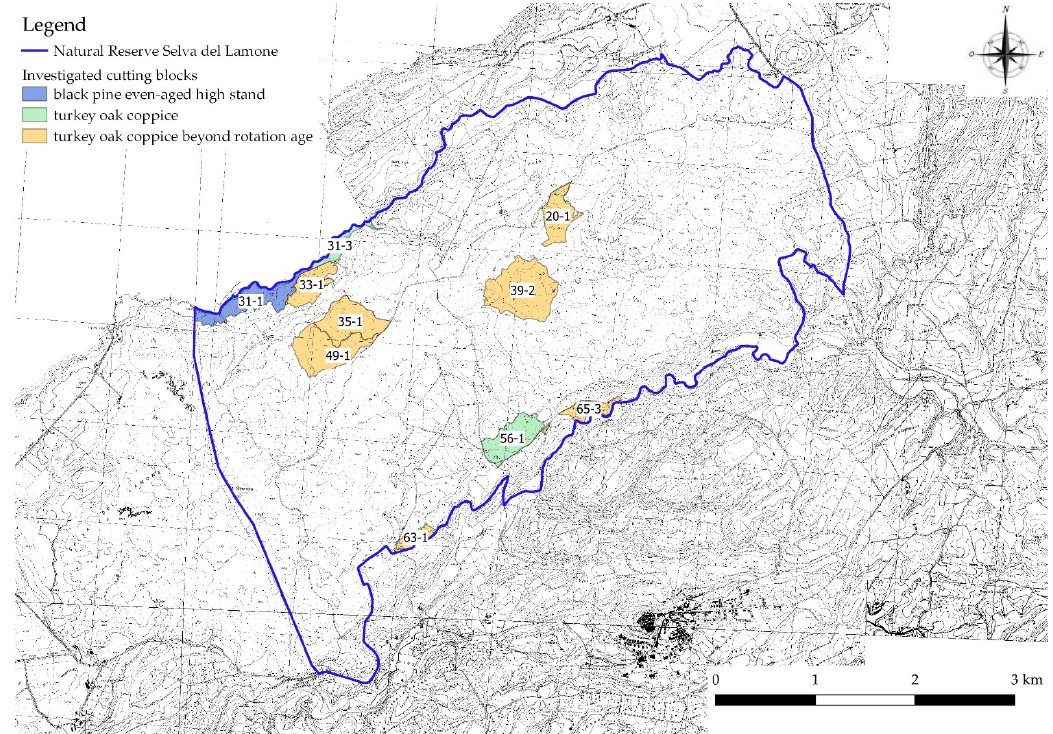
Figure 2. Details of the investigated cutting blocks.